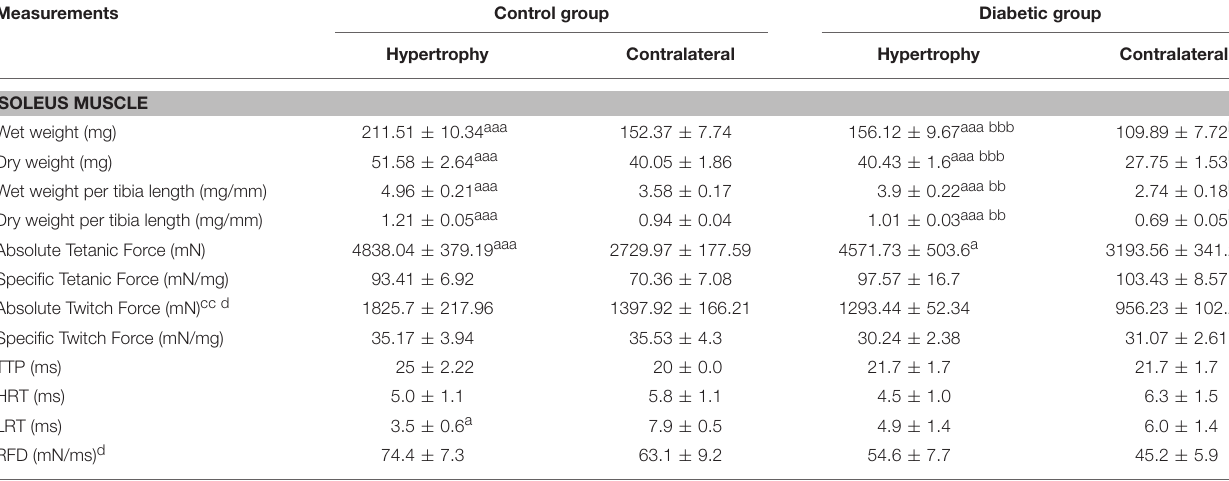
TABLE 3 | Soleus mass, strength, and contractile properties after 30 days of